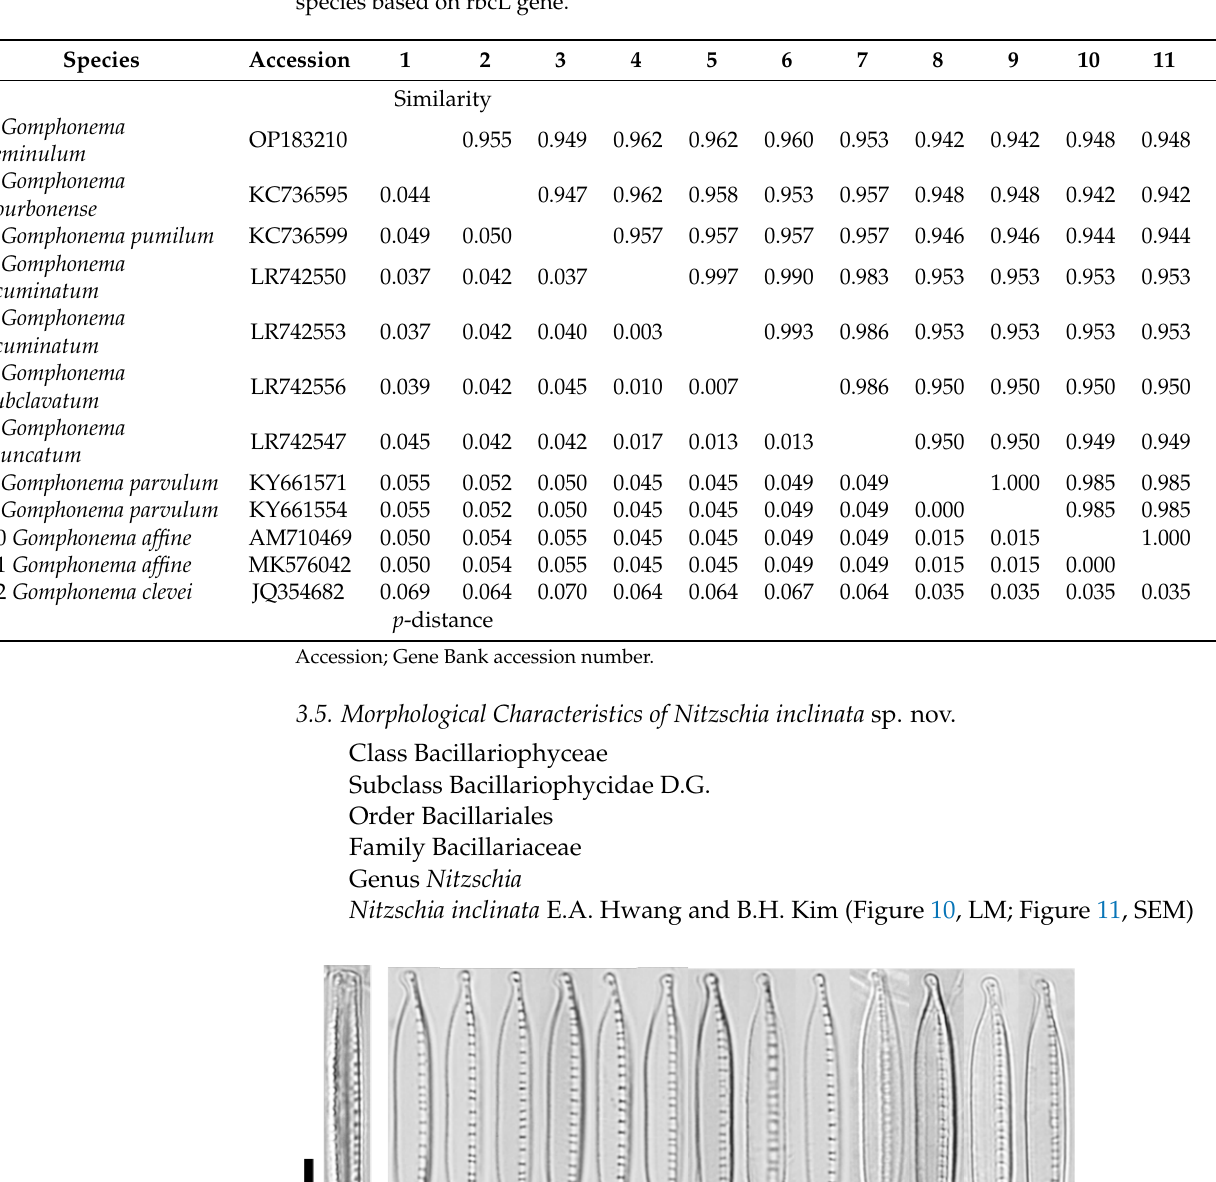
Table 7. Similarity scores and genetic distances among 12 aligned sequences (596 bp) of Gomphonema species based on rbcL gene.